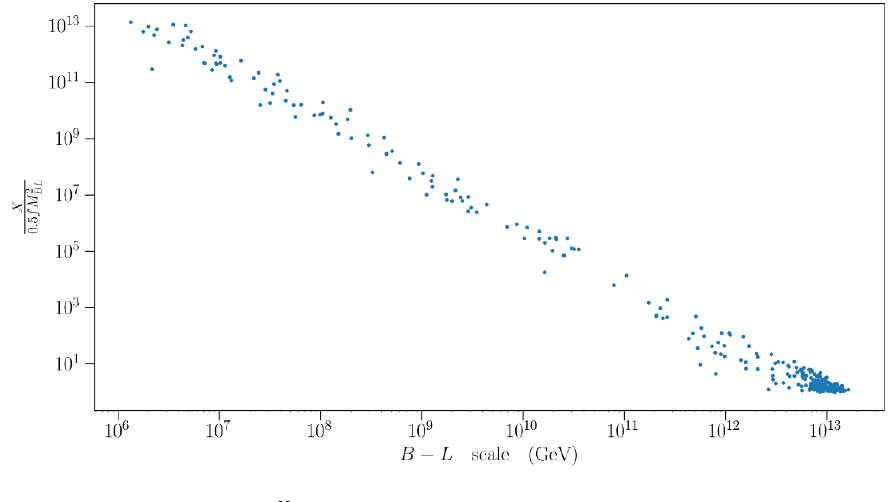
against the B - L scale, for the valid black points shown in 1 fM 2 BL 2